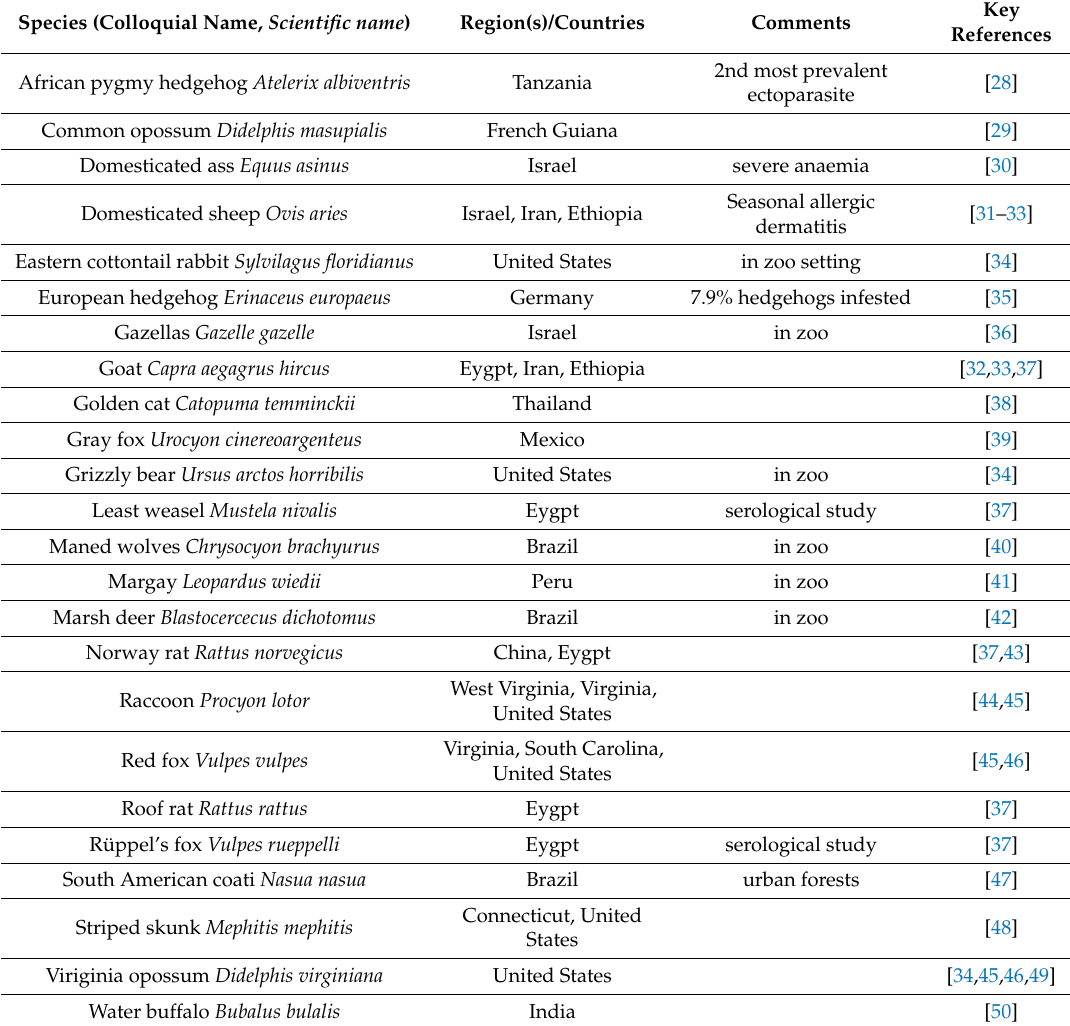
Table 1. Summary of C. felis hosts other than cats and dogs a